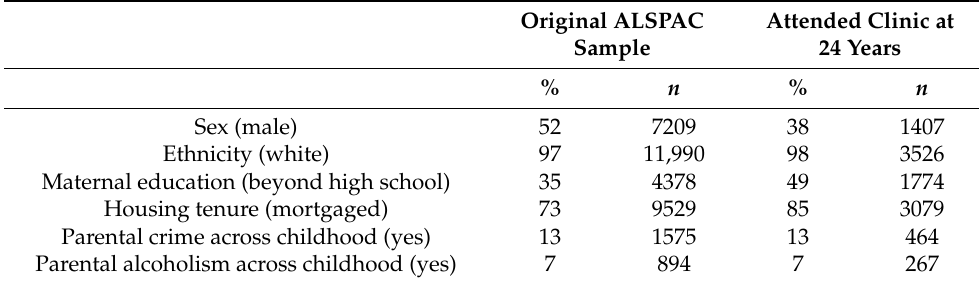
Table 1. Comparison of sociodemographic and parental characteristics for the original ALSPAC sample ( n ≤ 13,960) and those that attended the clinical assessment at age 24 years ( n ≤ 3726). Original ALSPAC Attended Clinic at Sample 24 Years % n % n Sex (male) 52 7209 38 1407 Ethnicity (white) 97 11,990 98 3526 Maternal education (beyond high school) 35 4378 49